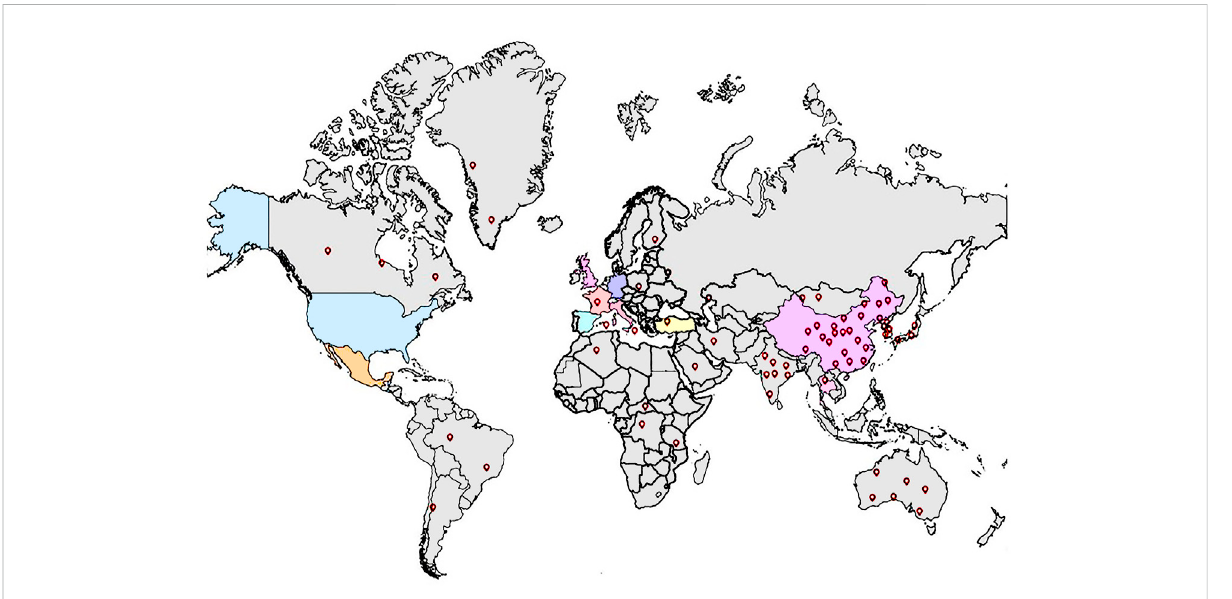
FIGURE 2 Geographical distribution of Rubia cordifolia L (world map from: https://www.onlinedown.net/soft/197029.htm) in the world (The red surface symbol map shows the distribution area of R. cordifolia